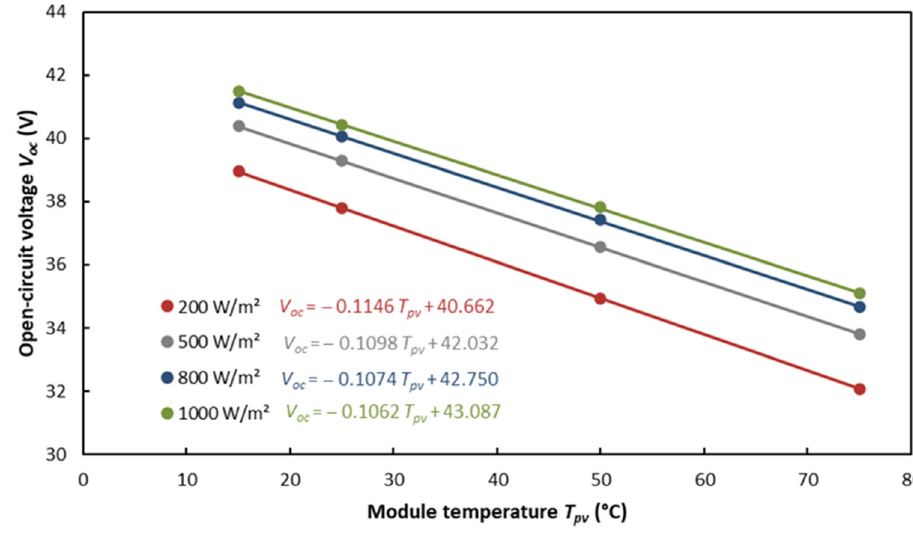
Figure 8. Open-circuit voltage dependence to module temperature at various irradiance levels. Figure 8. Open ‐ circuit voltage dependence to module temperature at various irradiance levels.